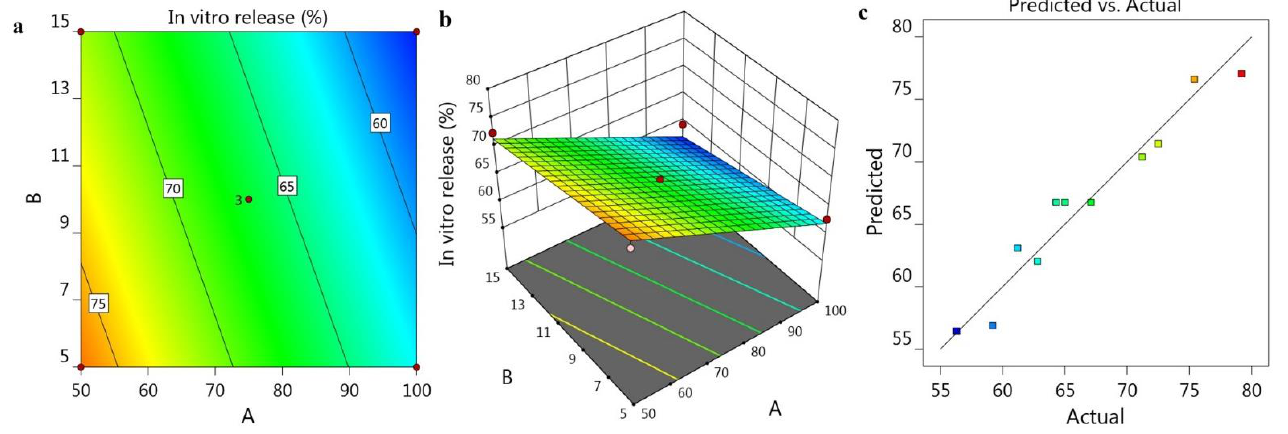
Figure 4. Representing ( a ) 2D-Contour plot, ( b ) 3D-Response Surface Plot and ( c ) linear correlation plot between predicted against actual values.